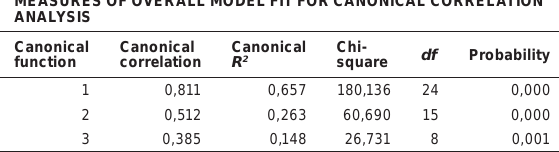
Table 6 Canonical correlation analysis for the CCQ domains and the WLQ scales